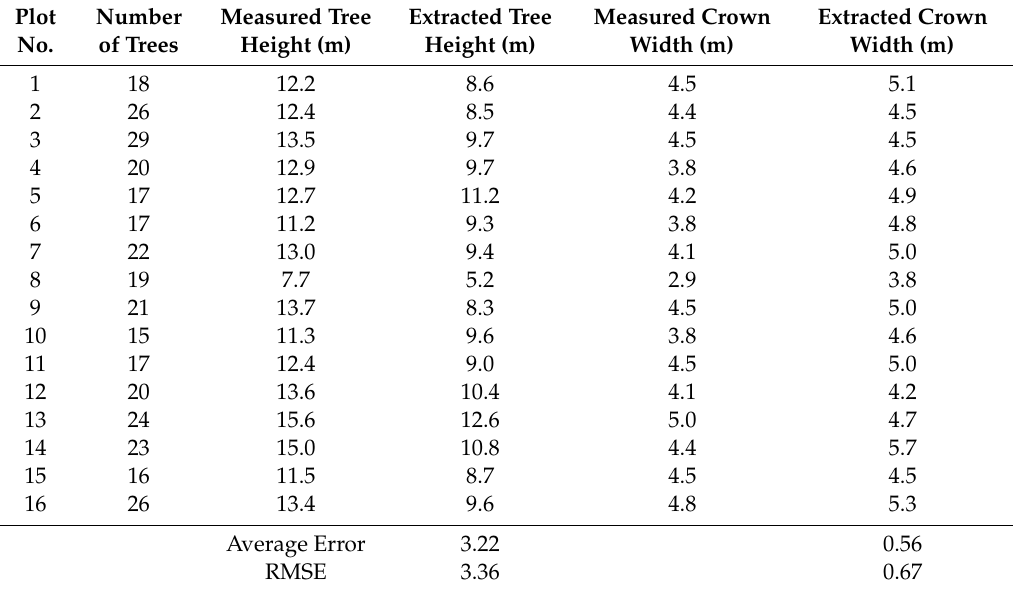
Table 8. The statistics of the tree extracted by template-matching algorithm (cone) in 16 super plots. Plot Number No. of Trees